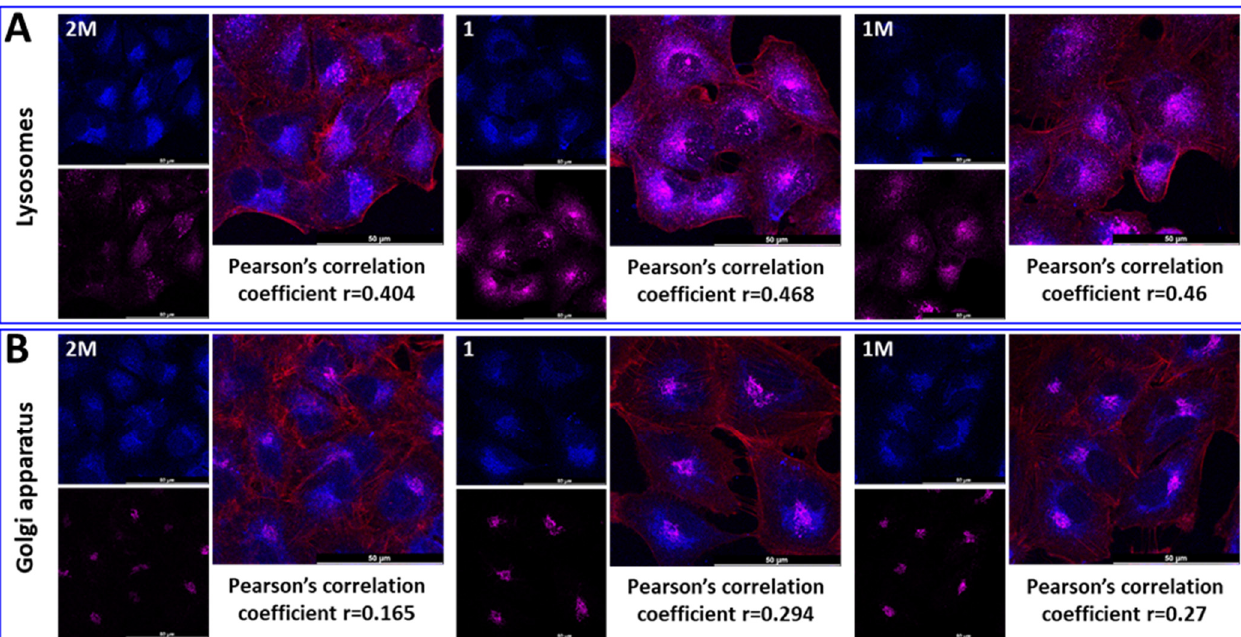
with PFA, and subsequently stained with anti GM130 antibody. Colocalisation is assessed by the Pearson correlation coefficient. Analysis was conducted using ImageJ software and the appropriate JACoP plugin [53].